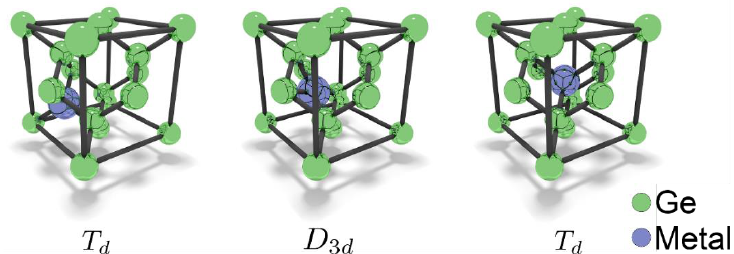
Figure 5. The calculated, by Tahini et al. [64], minimum migration energy mechanism is the direct interstitial process Pd i ↔ Pd i . Copyright 2015 Royal Society of Chemistry [64].